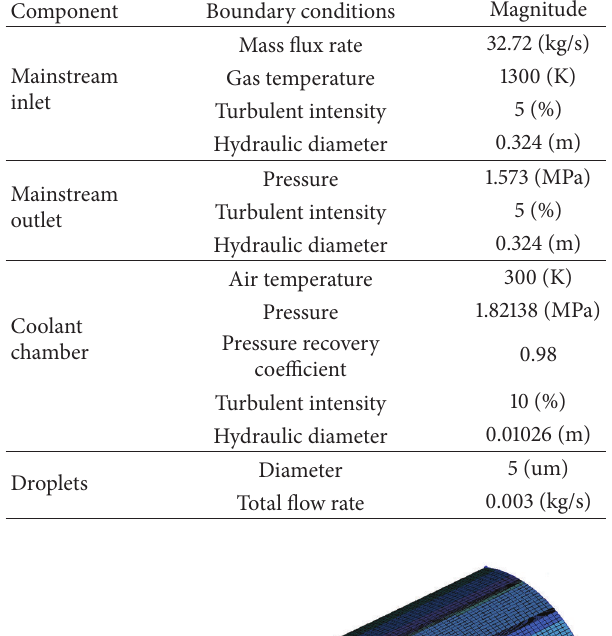
Table 1: Boundary conditions.